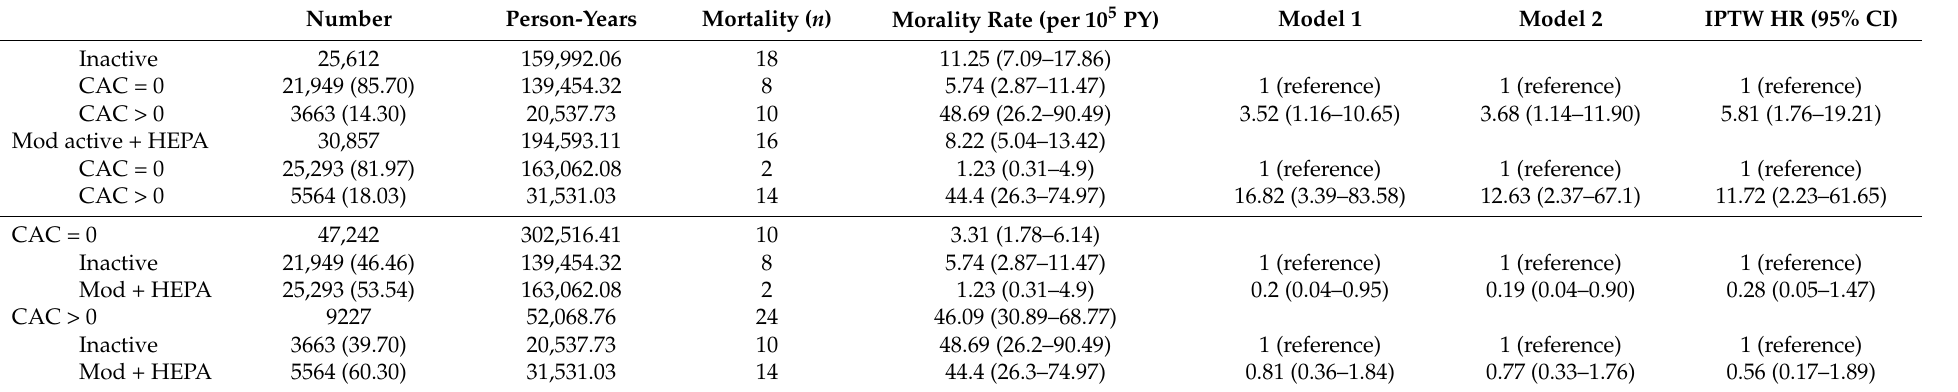
Table 3. Mortality rates based on physical activity levels and CAC.